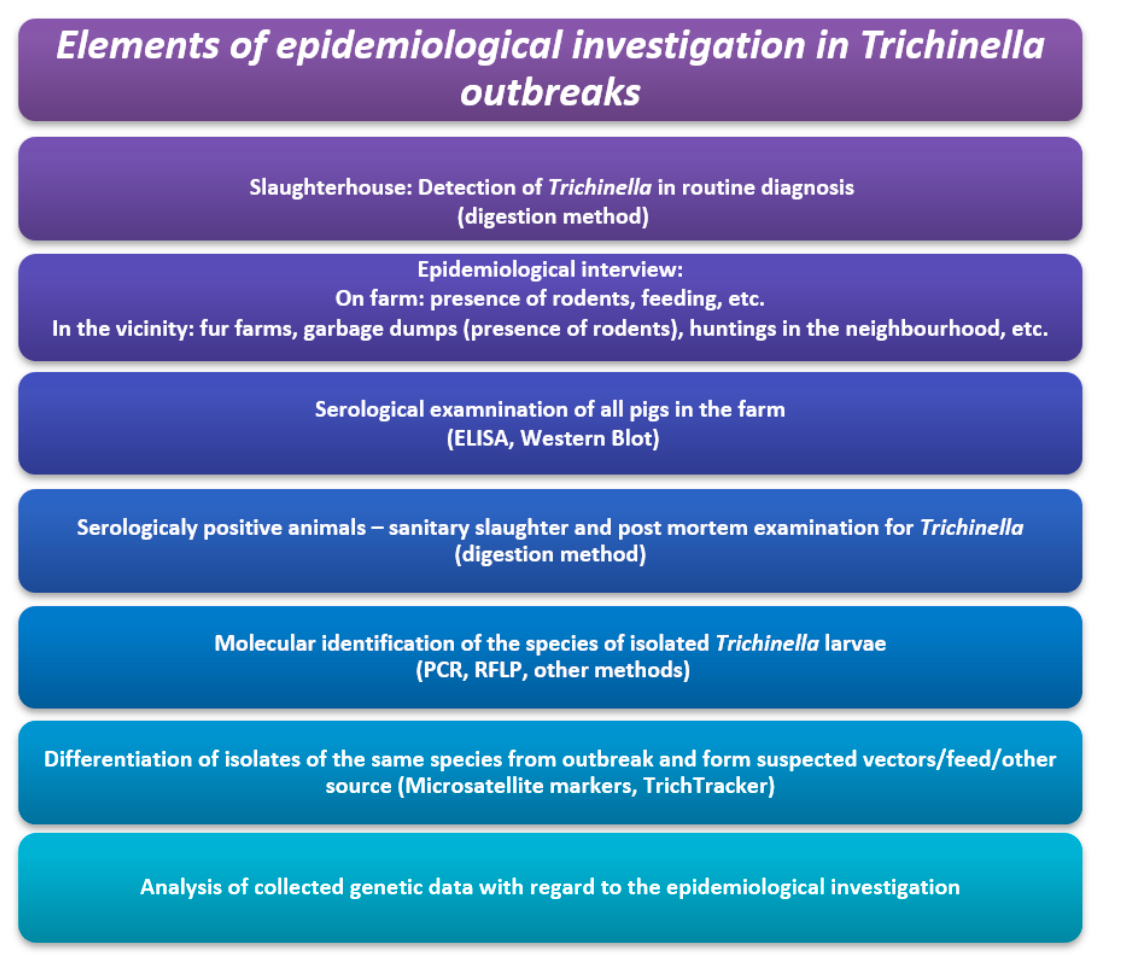
Figure 1. Elements of epidemiological investigation in Trichinella outbreaks.